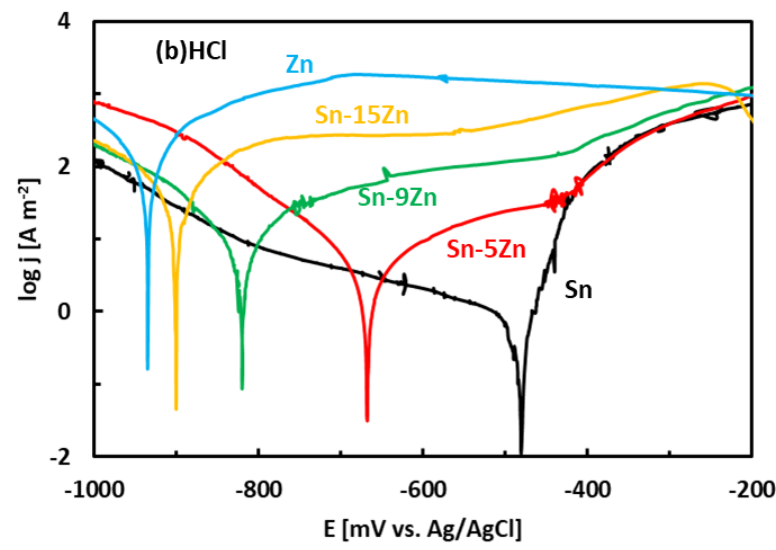
Figure 5. Potentiodynamic polarization curves of the Sn – Zn alloys in NaCl ( a ) and HCl ( b ) solutions. The experimental polarization curves have been analyzed by Tafel extrapolation of the cathodic and anodic curves [34]. The corrosion parameters (E corr , j corr ) obtained by Tafel extrapolation are presented in Figure 6 and Table 2. The experimental electrochemical pa- rameters of the Sn – Zn alloys obtained by previous authors are also included in Figure 6 [15,19,46]. The corrosion potentials of the alloys in HCl increased with increasing Sn con- centration. Furthermore, the corrosion currents of the Sn – Zn alloys decreased with in- creasing Sn concentration, indicating that a higher Sn content contributes to the higher corrosion resistance of the alloys.